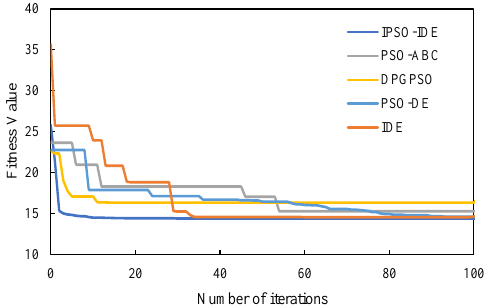
Figure 12. Convergence curves of optimal fitness values based on different algorithms in environment 3. Table 6. Path planning results of different algorithms in environment